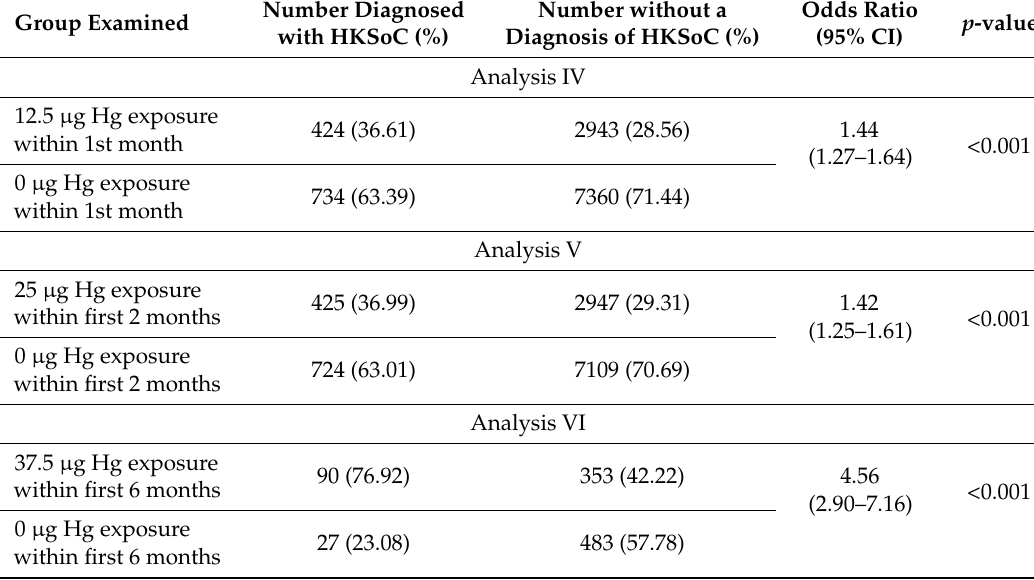
Table 3. A summary of organic-mercury exposure from Thimerosal-preserved hepatitis B vaccine administration between male cases diagnosed with hyperkinetic syndrome of childhood (HKSoC) and male controls within the Vaccine Safety Datalink